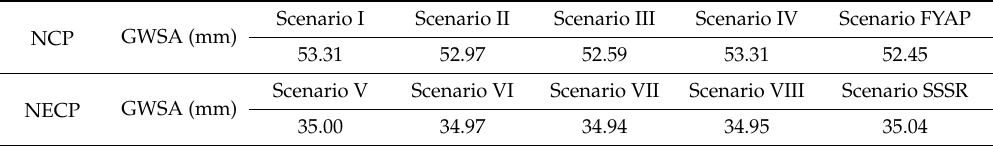
Table 5. The monthly errors of GWSA from simulated scenarios (2003–2016). FYAP and SSSR stand for Five Year (2018–2022) Action Plan for Integrated Governing of Groundwater Overexploitation in the Hebei Province and Supply-Side Structural Reforms,